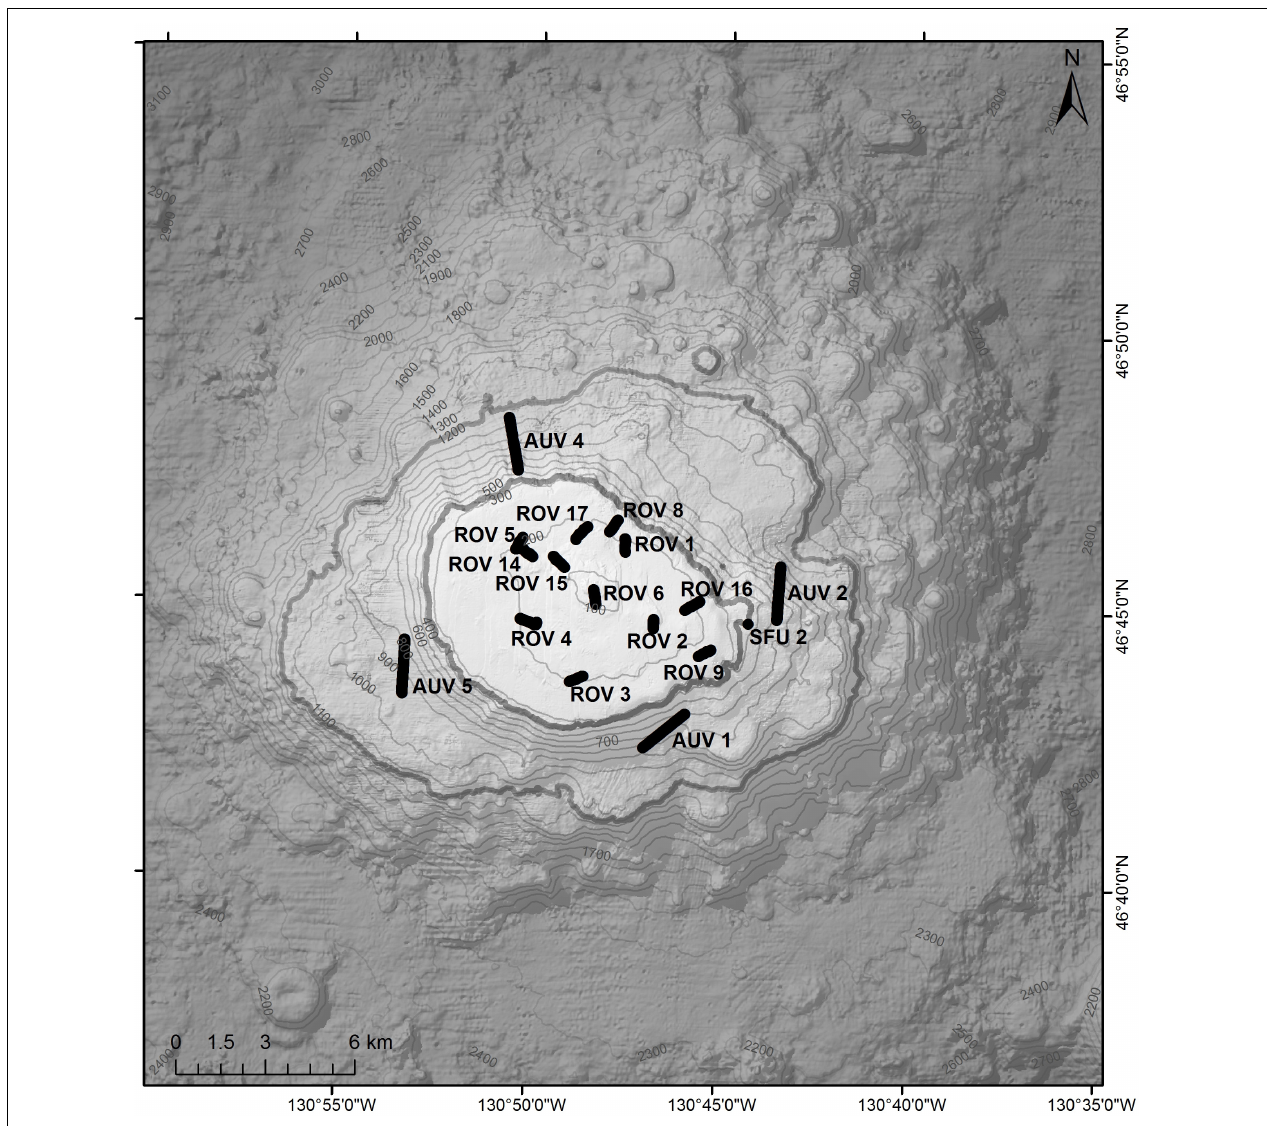
FIGURE 2 | The study area, topography, and transects. Black lines show the locations of the 17 visual survey dives in 2012 on Cobb Seamount, an unusually shallow guyot rising from ∼ 2750 m depth ( ∼ map boundary) to within 24 m of the surface. The imagery of the pinnacle and shallow seamount summit plateau was collected using a remotely operated vehicle (ROV), imagery at the summit ridge was collected using a ROV during a single short, aborted dive (SFU), and the imagery of the upper flanks was collected using an autonomous underwater vehicle (AUV). The maximum depth for the ROV dives was ∼ 225 m, the SFU dive was at ∼ 350 m (bold contour), and the maximum depth for the AUV dives was ∼ 1200 m (bold contour). Contour lines = 100 m depth